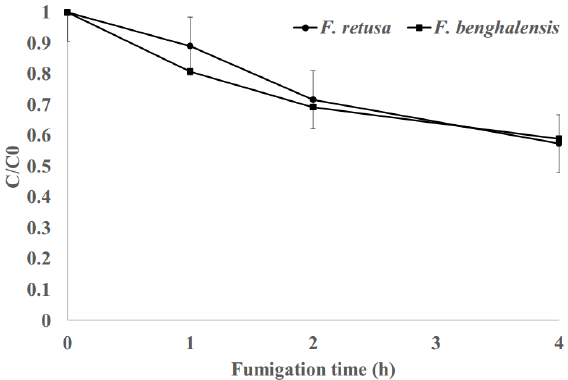
Figure 1. Concentration loss of ethyl formate (EF) (C/C 0 ) in 0.275 m 3 fumigation chamber with 5% loading ratio ( w / v ) of potted imported rubber plants ( Fiscus retusa and F. benghalensis ). EF was treated at 35 g/m 3 for 4 h at 15 ◦ C C = EF concentration determined at one of the time intervals and C 0 = EF concentration at 0.1 h. EF concentration was determined at 0.1, 1.0, 2.0, and 4.0 h after EF had been applied to the fumigation